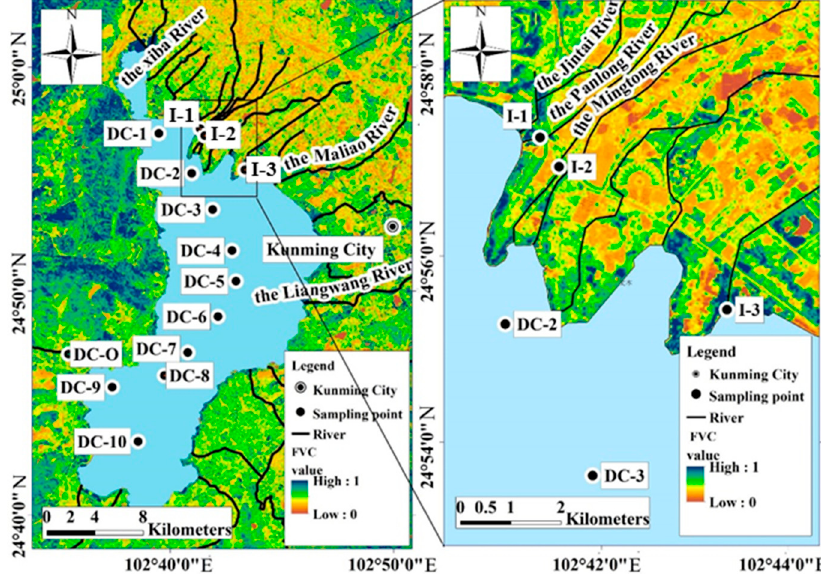
Figure 1. Location of Dianchi Lake in Yunnan Plateau and the sampling sites. FVC value: fractional vegetation cover value.